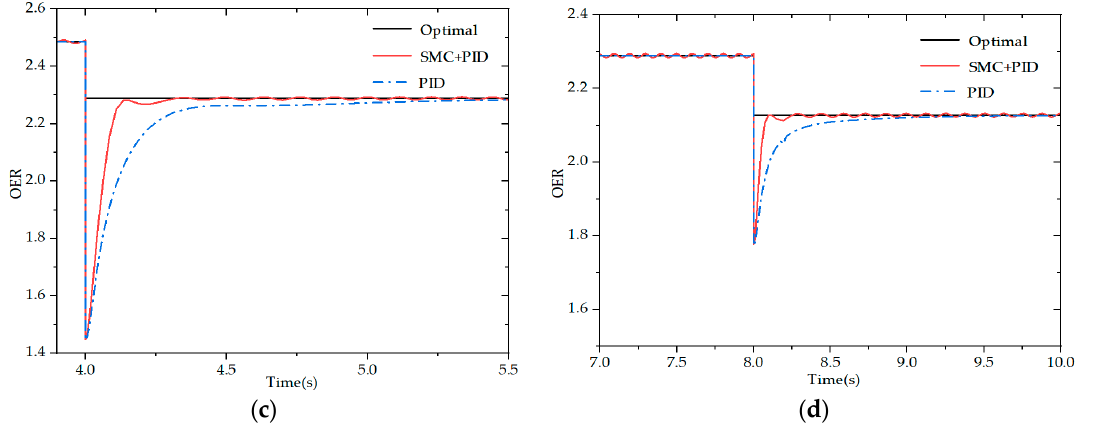
Figure 7. ( a ) OER results of PID and SMC controller cascade control and PID control under various loads are compared in simulation. ( b – d ) are local magnifications of simulation OER.